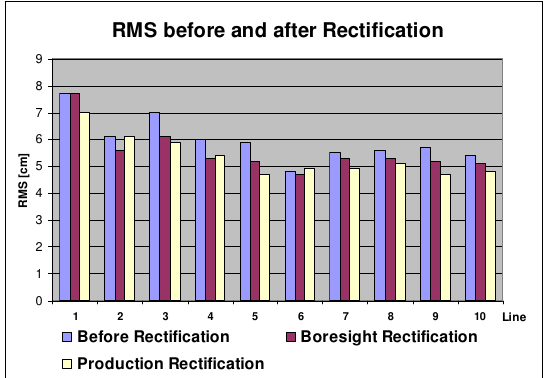
Figure 6. RMS values before and after